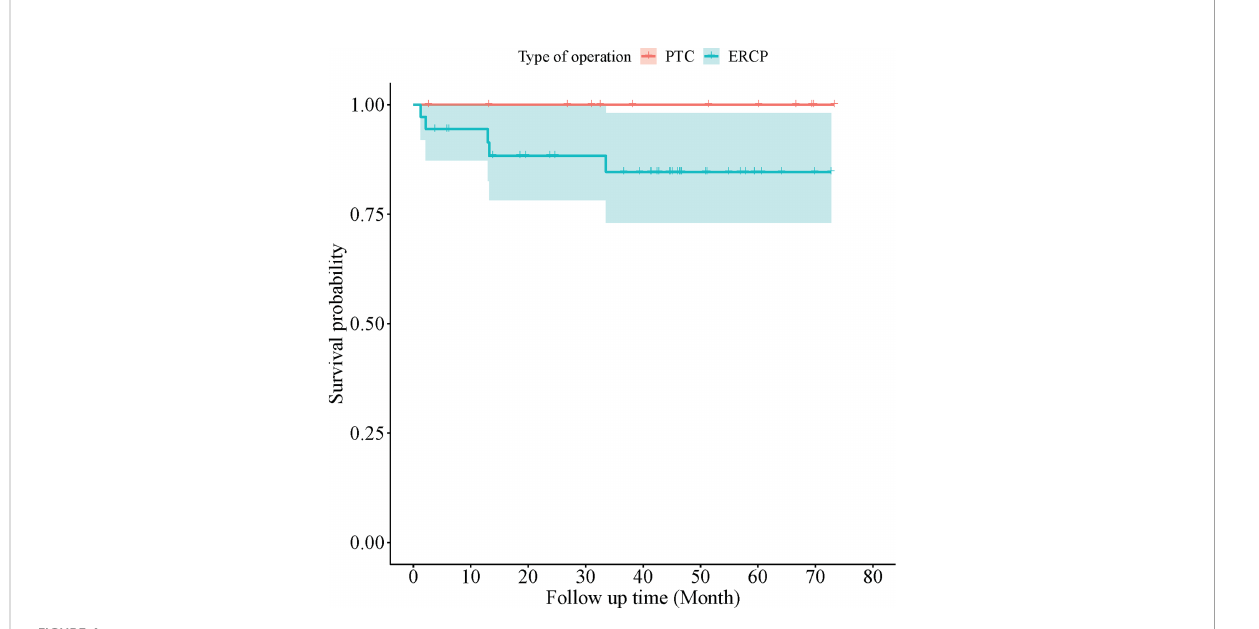
FIGURE 4 Kaplan-Meier survival analysis in 36 ERCP patients and 12 PTC